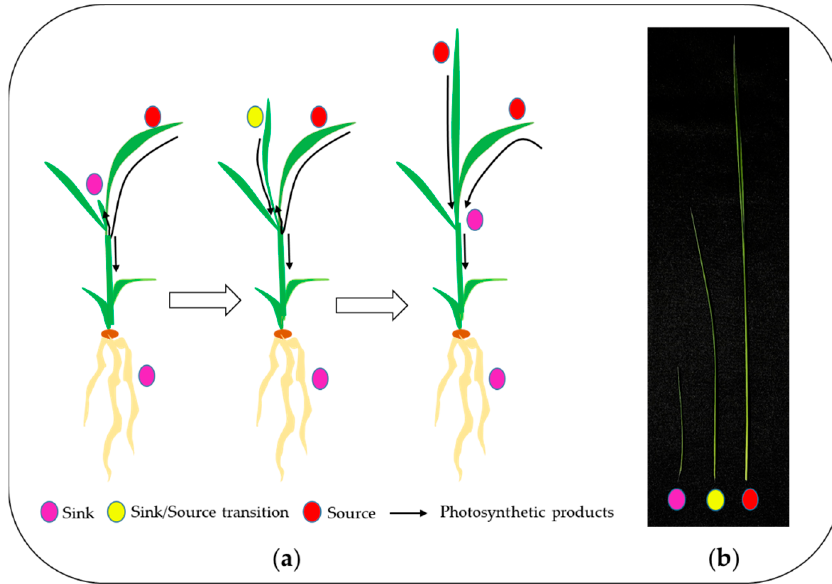
Figure 1 . Transition process from sink to source tissue in rice seedlings ( a ) and 5th leaf blade at three different stages ( b ) (magenta, Day 1; yellow, Day 3; red, Day 5).